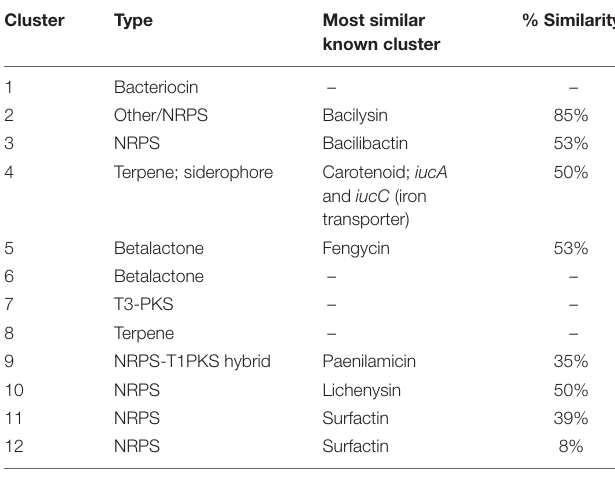
TABLE 3 | BGCs clusters identified in the B. pumilus 64-1 genome by the antiSMASH platform.